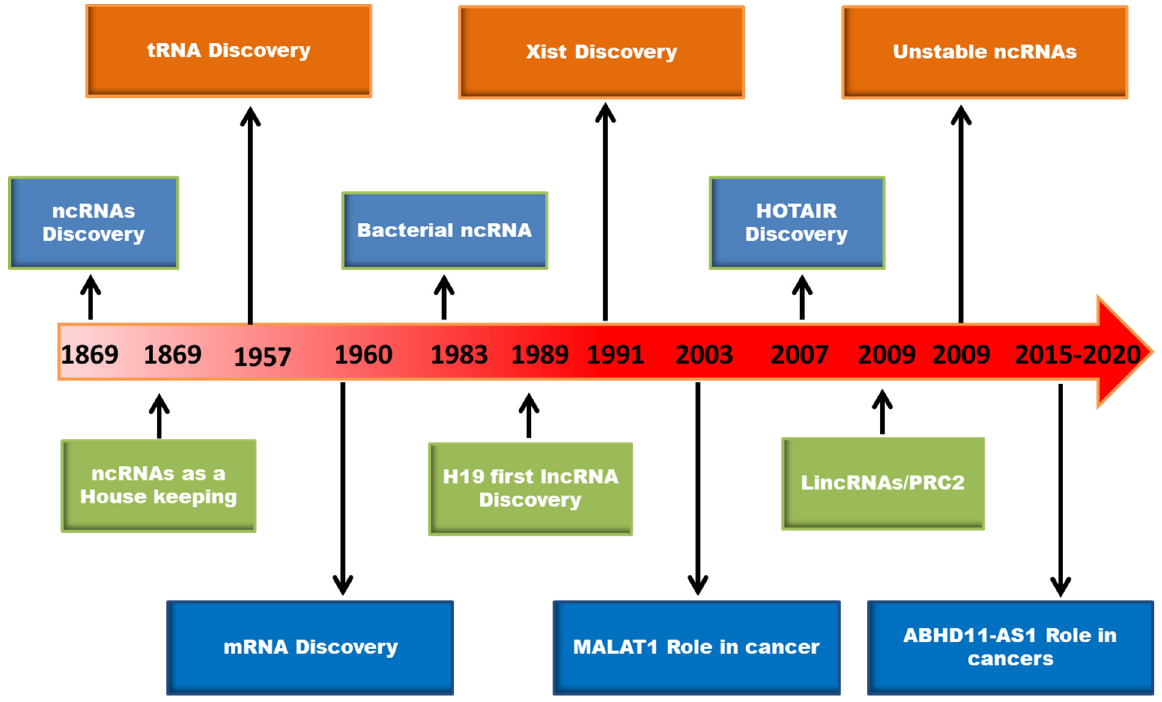
Figure 1. The timeline of major discoveries in the area of RNA biology.